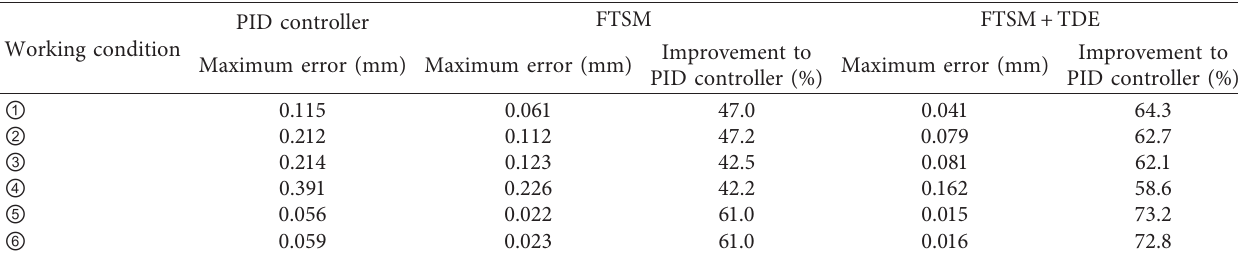
Figure 13: Position error of working condition ⑥ in Table 4. Table 6: HDU position error under different control